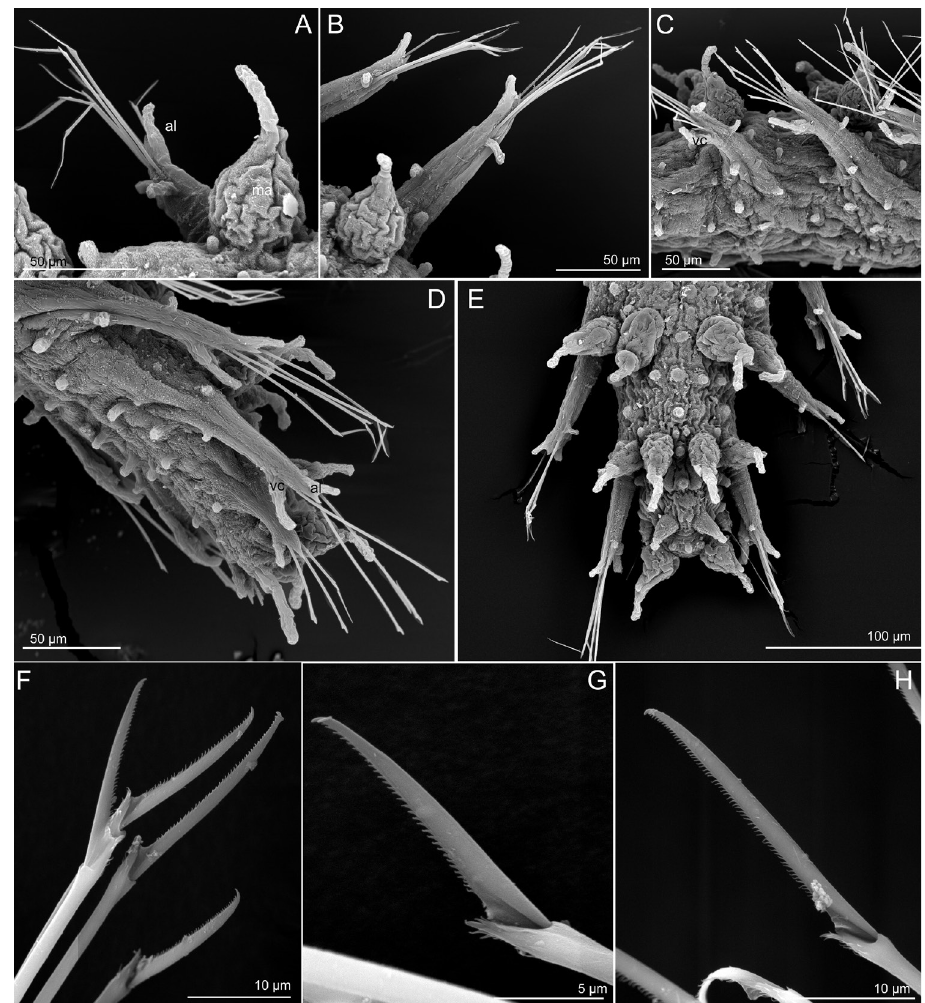
Figure 6. Sphaerephesia amphorata sp. n., paratypes, USNM 1002041, SEM. A Anterior parapodium, dorsal view B Mid-body parapodium, dorsal view C Mid-body chaetigers, lateroventral view D Posterior end, side view E Posterior end, dorsal view F Chaetae anterior parapodium G, H Detail of chaetae, mid- body chaetiger. Abbreviations: al, acicular lobe; mc, macrotubercle; vc, ventral